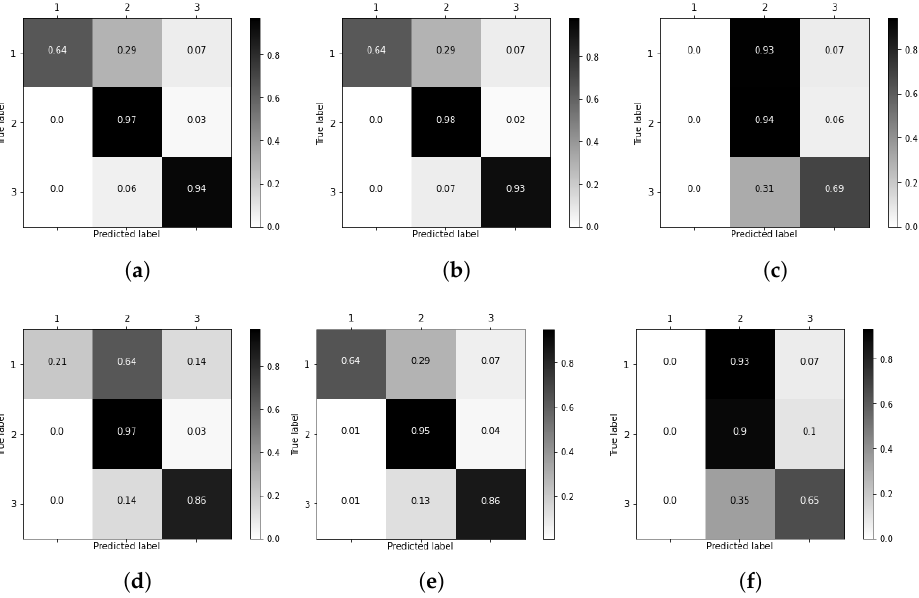
Figure 4. Confusion matrices for classifier comparison and performance analysis. ( a ) AdaBoost, ( b ) XGBoost, ( c ) Gradient boosting, ( d ) Random bagging, ( e ) CART, and ( f ) Voting